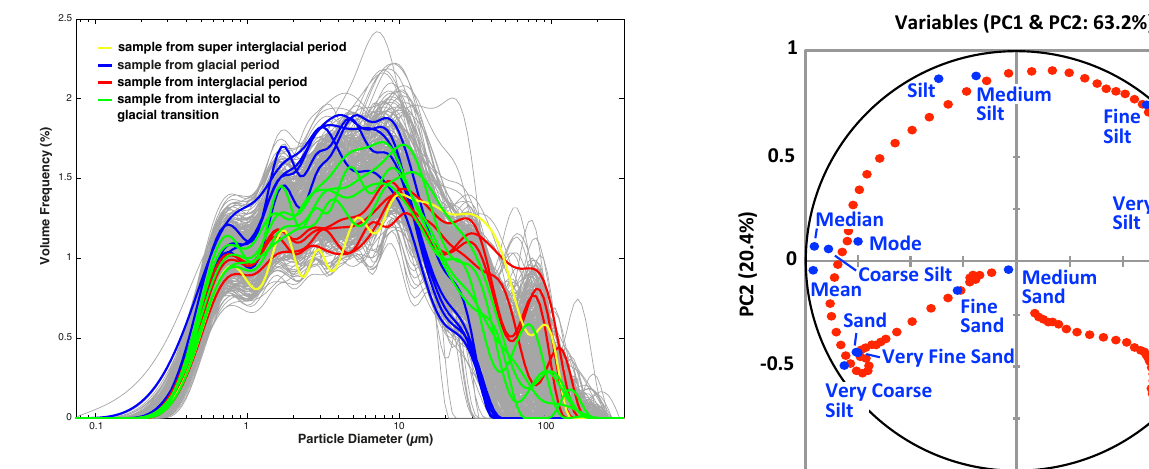
Fig. 3. Grain-size distributions of all analyzed samples from ICDP core 5011-1: blue: samples from glacial periods (facies A); green: samples from interglacial-to-glacial transitions; red: samples from interglacial periods (facies B); yellow: samples from super inter- glacial conditions (facies C).